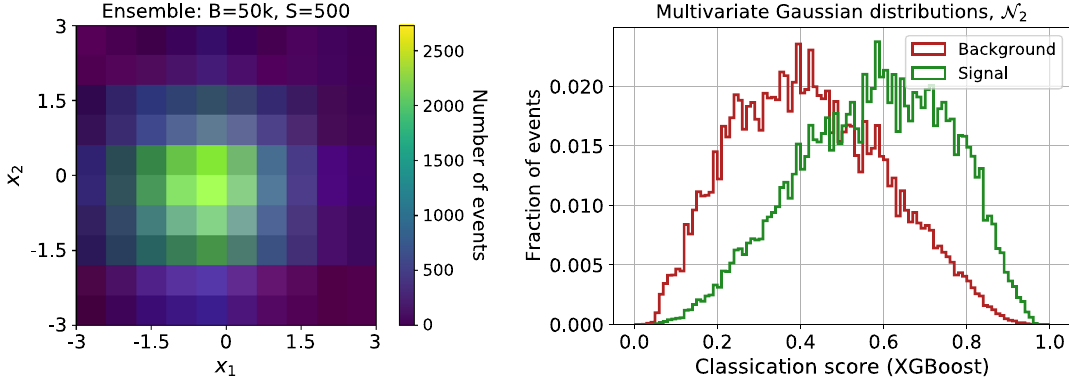
Fig. 2 Left panel: histogram of an hypothetical experiment with B = 50k and S = 500 events divided into 10 × 10 bins. Signal and background distributions can be seen in Fig. 1. Right panel: classification score, o ( x ) , for a binary classifier using the XGBoost algorithm